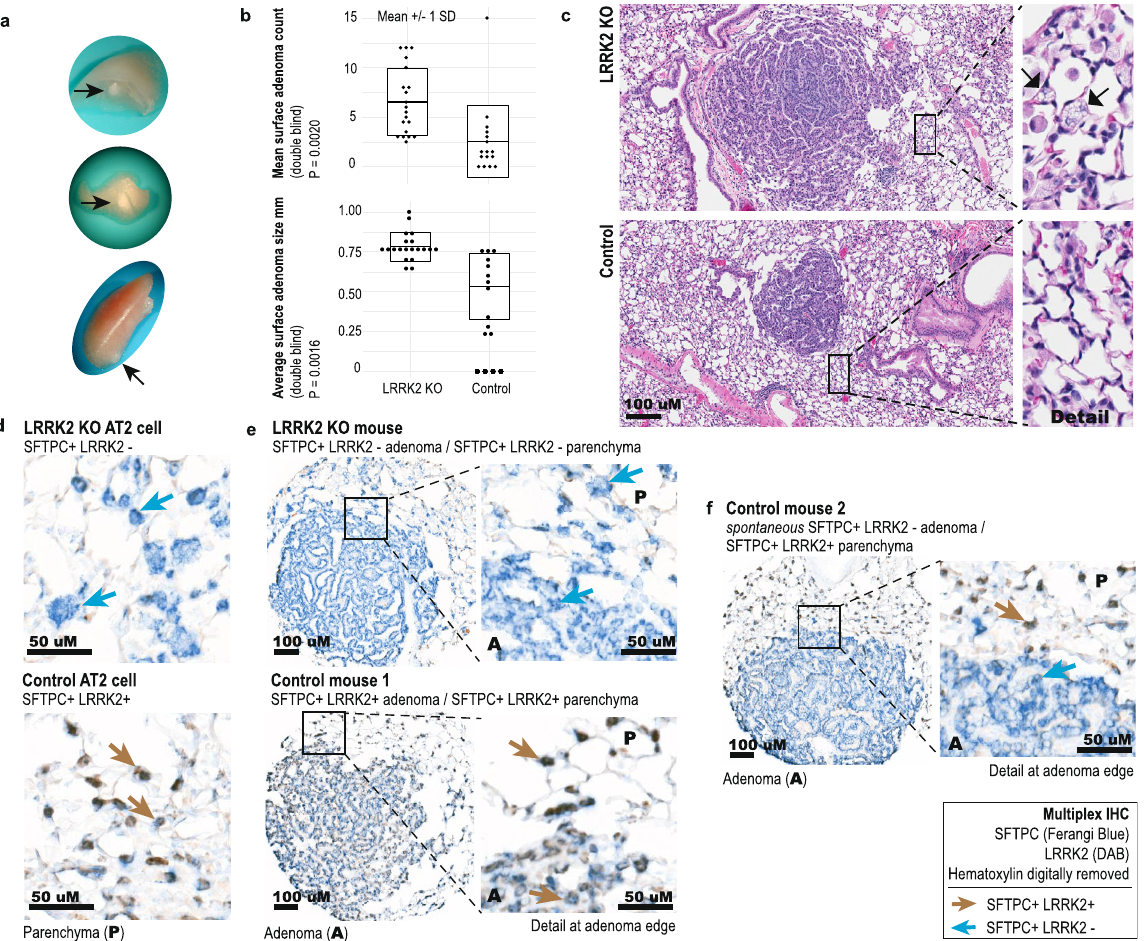
Figure 3. LRRK2 knockout increases SFTPC-positive tumor initiation in a murine model of urethane-induced, early stage lung cancer. ( A ) Representative visible adenomas that developed in the lungs of both LRRK2 knockout (KO) mice and wild type (WT) strain mates, following urethane treatment. ( B ) Double blind analysis of adenoma counts and size (n = 16 WT and n = 20 LRRK2 KO animals, with n = 40 WT and n = 130 LRRK2 KO surface lesions). ( C ) Representative H&E stained sections of adenomas (20× magnification; transverse section; n = 16 WT and n = 20 LRRK2 KO animals, with n = 40 WT and n = 130 LRRK2 KO surface lesions). (Inset) Detailed view of representative vacuolated cells (arrows) found in LRRK2 KO lung only. ( D ) Representative images of multiplexed IHC staining for colocalization of alveolar type II (AT2)-specific cell marker SFTPC (Ferangi blue chromogen) and LRRK2 (3,3 ′ -Diaminobenzidine (DAB) chromogen), in LRRK2 KO (top) and WT (bottom) mouse lung parenchyma (n = 7 WT mice with 14 lesions; n = 15 KO mice with 25 lesions). ( E ) Representative images of multiplexed IHC staining for SFTPC and LRRK2, in adenomas that developed in the lungs of both LRRK2 KO (top) and WT (bottom) control mice, following urethane treatment (n = 7 WT mice with 14 lesions; n = 15 KO mice with 25 lesions). (Inset) detailed view of staining at adenoma edge and adjacent lung parenchyma. ( F ) Representative images of multiplexed IHC staining for SFTPC and LRRK2, for adenomas that developed in the lungs of WT control mice following urethane treatment, showing spontaneous reduction of LRRK2 positivity. Representative of 4 of 14 lesions from n = 7 WT control mice. (Inset) AT2 cells in the adjacent lung parenchyma remained double positive for SFTPC and